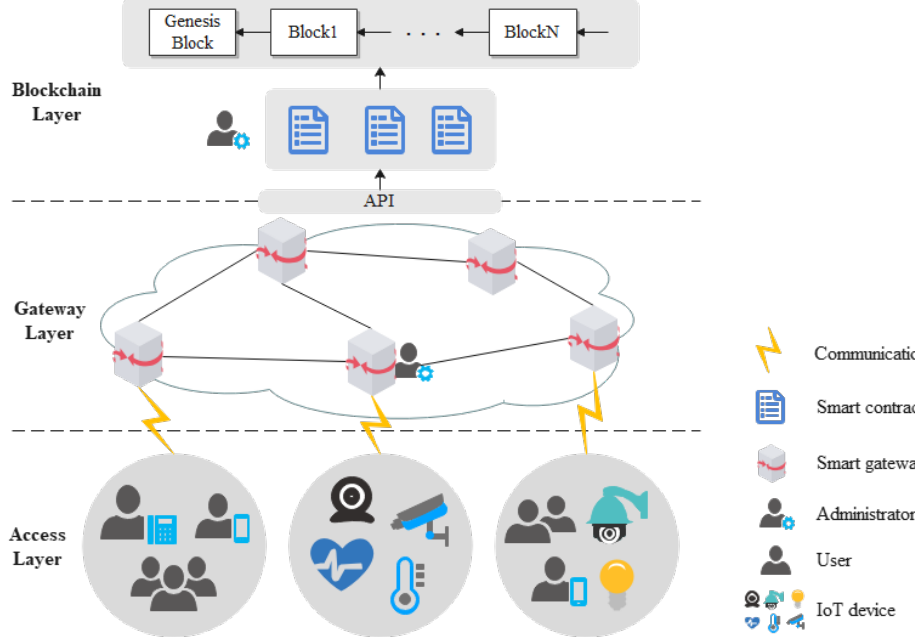
Figure 1. System architecture.